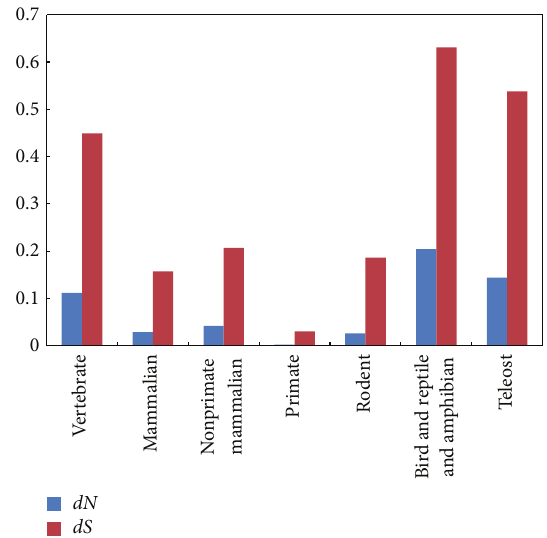
Figure 3: Pairwise comparisons of dN and dS among 28 vertebrate FKBP25 sequences. Figure 4: The average nonsynonymous ( dN ) and synonymous ( dS ) in FKBP25 from different vertebrate groups. The value of average dN was in blue, and the value of average dS was in